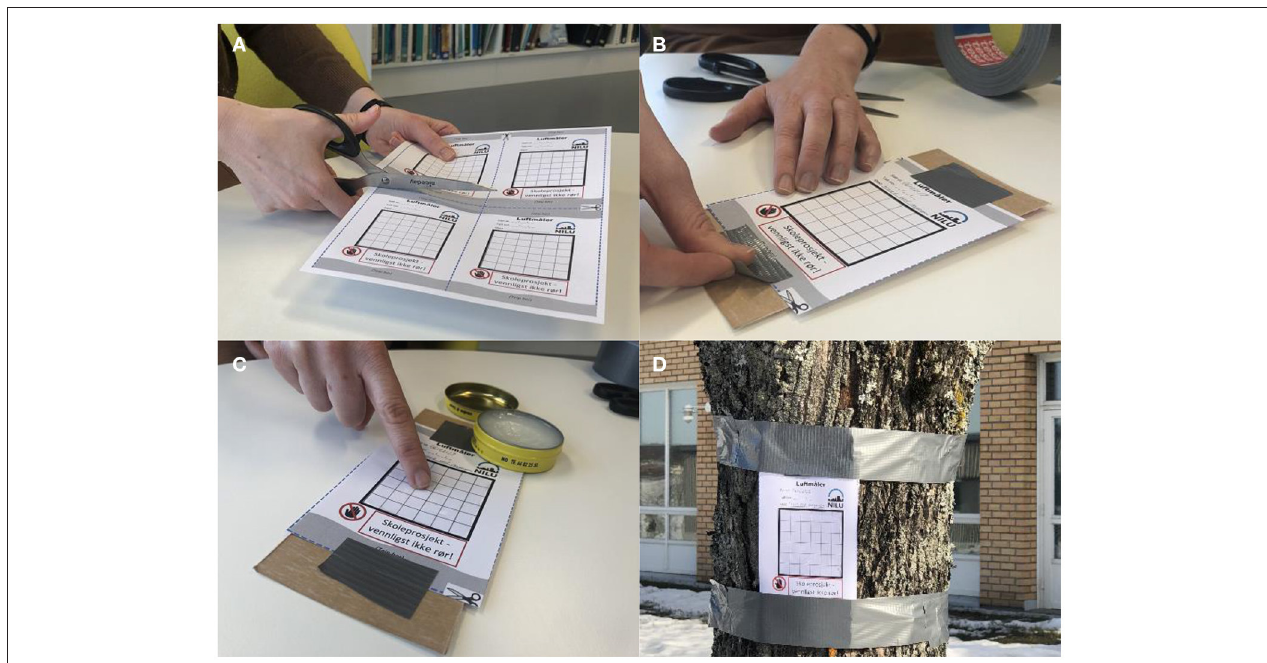
FIGURE 2 | (A) After printing the air meter, the students can cut it. (B) The air meter is attached to a milk carton box using silver tape. (C) A thin layer of petroleum jelly is applied using the finger. (D) The air meter is deployed outside using silver tape.